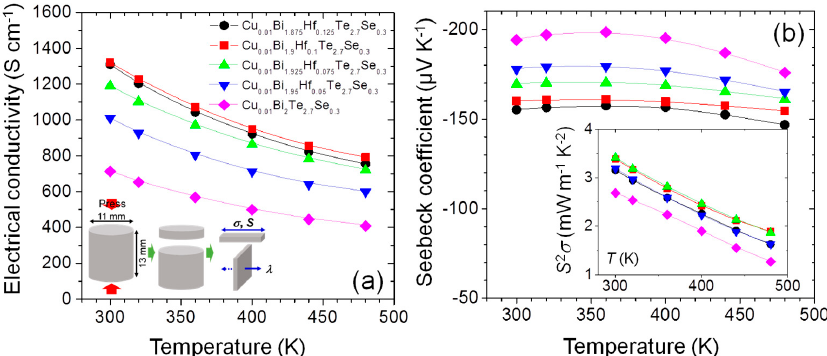
Figure 2. Temperature dependences of the ( a ) electrical conductivity ( σ ) and ( b ) Seebeck coefficient ( S ) for the SPSed Cu 0.01 Bi 2 ‑ x Hf x Te 2.7 Se 0.3 ( x = 0, 0.05, 0.075, 0.1, 0.125) bulks. Insets in ( a ) and ( b ) show the thermoelectric measurement orientations and the temperature ‑ dependent power factor ( S 2 σ ), respectively.